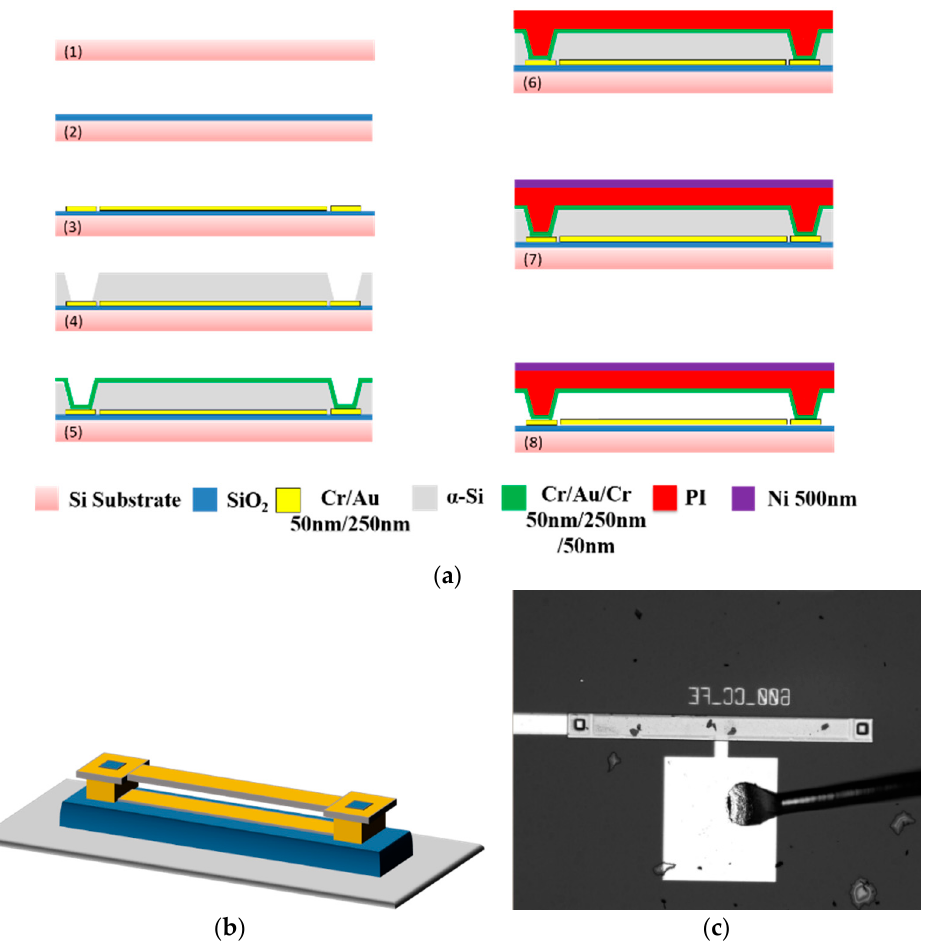
Figure 1. ( a ) The fabrication process flow of the clamped-clamped microbeam; ( b ) A schematic of an electrostatically actuated clamped-clamped microbeam; ( c ) An optical image of the fabricated microbeam.